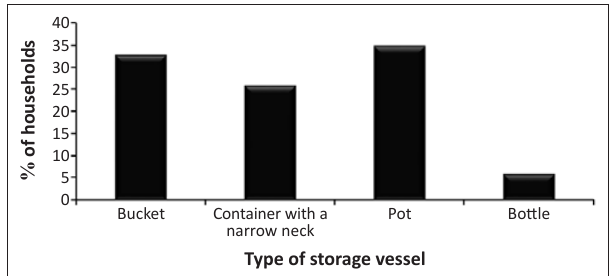
FIGURE 3 : Types of water storage vessels and their percentage use.